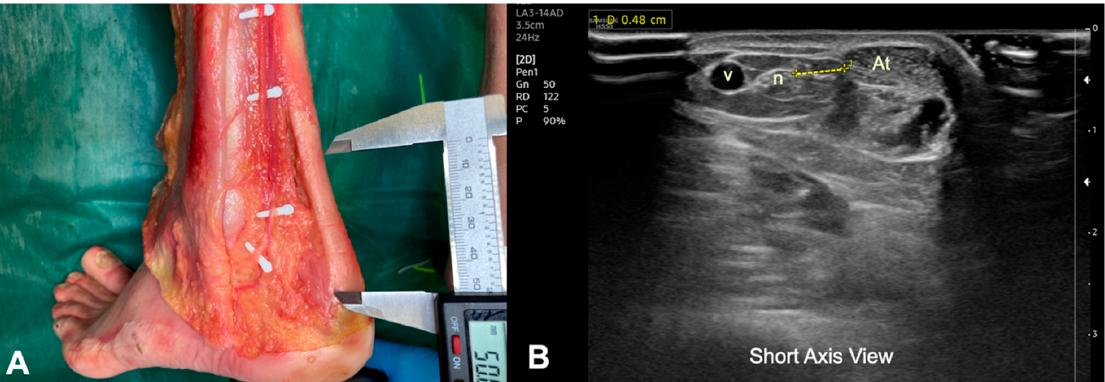
Figure 1. ( A ) Anatomical scheme of the course of the sural nerve and its relationship with the Achilles tendon on the lateral aspect of the ankle (white pins). Measurement in cadaver at 5 cm from the insertion in the calcaneus. ( B ) Ultrasound image (short axis view) of the relationship and measurement of the sural nerve with the lateral border of the Achilles tendon in a healthy volunteer. (At)—Achilles Tendon, (n)—Sural nerve, (v)—Lesser saphenous vein.